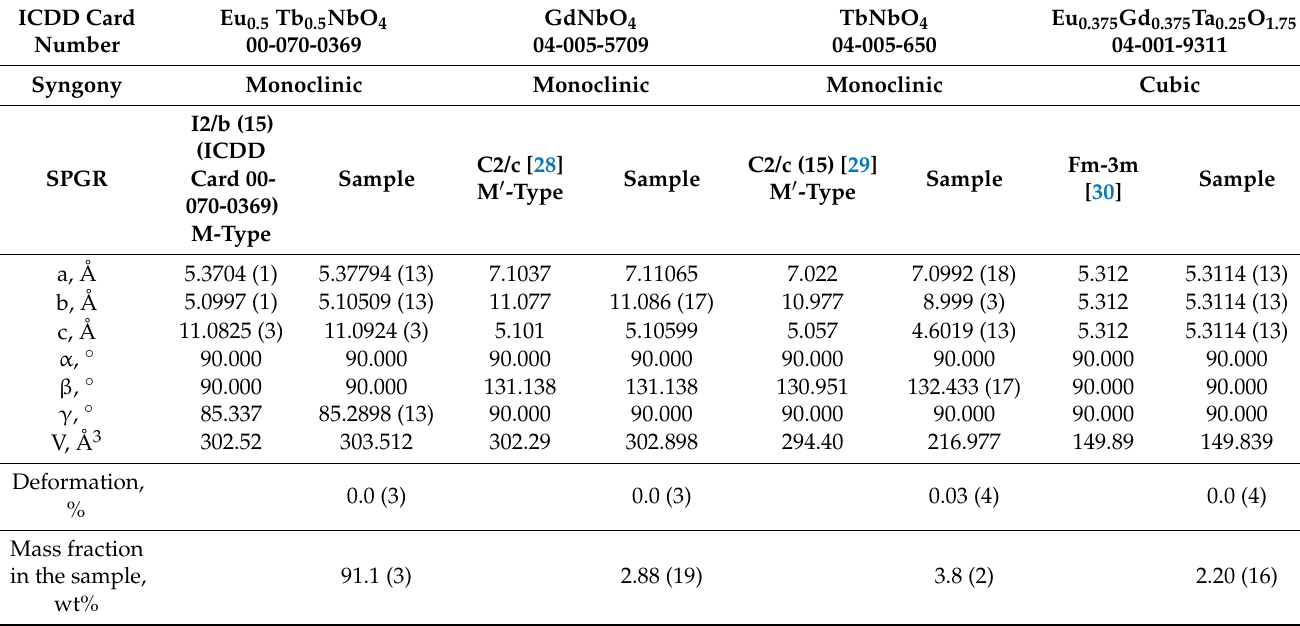
A series of SEM images characterize the morphology and grain sizes of the Gd 0.96 Eu 0.01 tures. Figure 2 demonstrates the microstructures and size compositions of the Gd 0.96 Eu